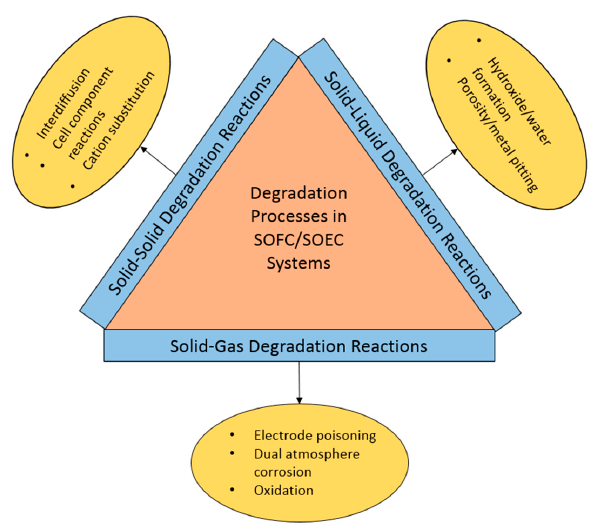
Figure 6. Schematic representation of the overall degradation processes in (solid oxide fuel cells) SOFC/SOEC systems.